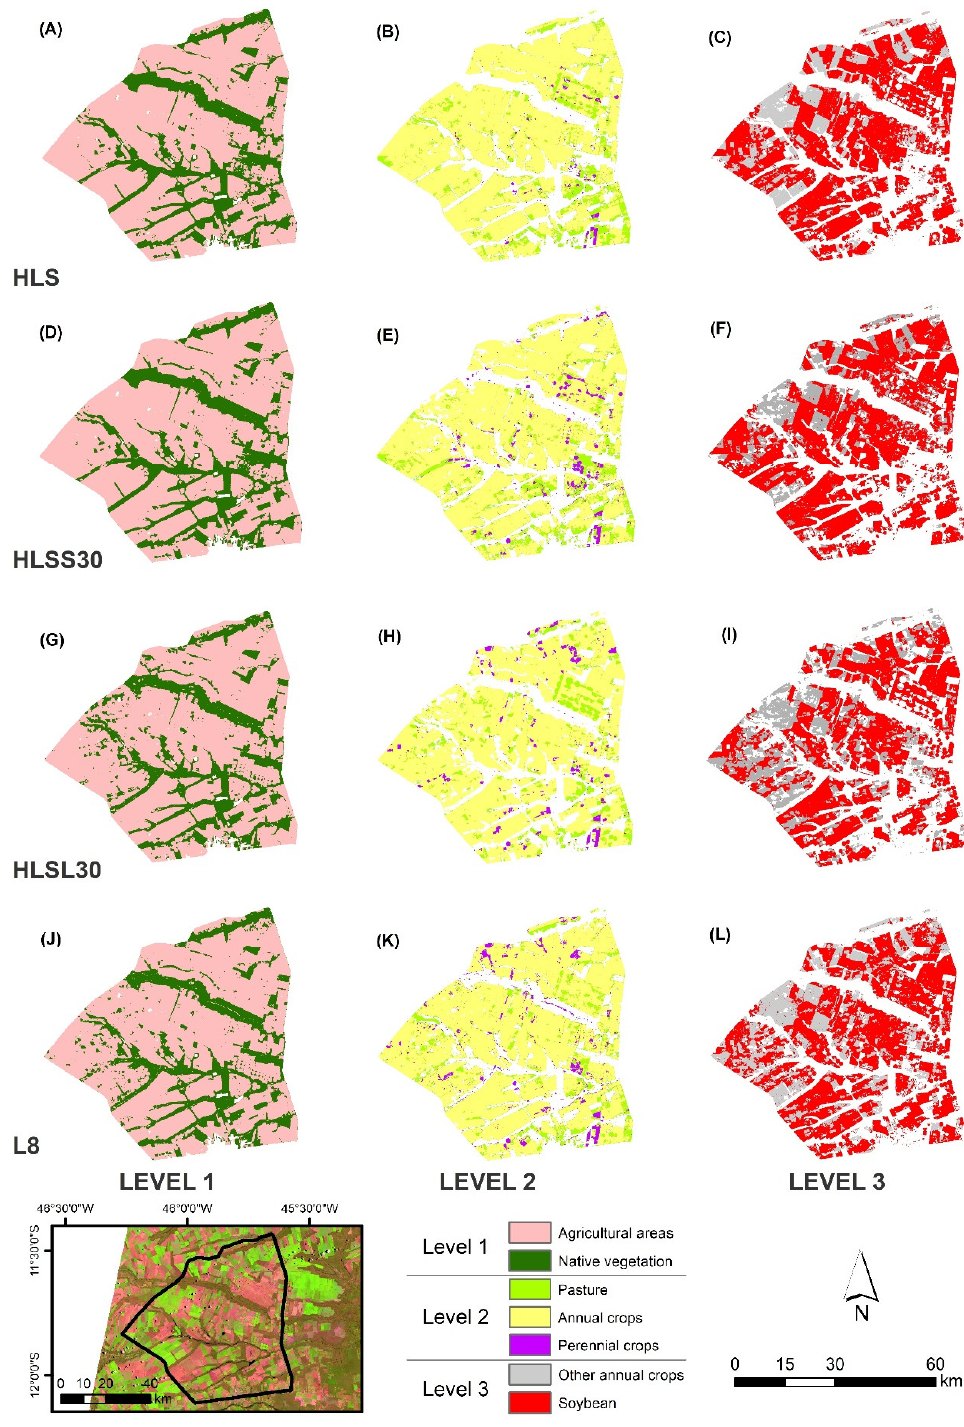
Figure 5. Random Forest classification results, based on Landsat 8 OLI and Harmonized Landsat Sentinel-2 (HLS) scenes, combining multispectral bands and spectral vegetation indices. ( A – C ) correspond to the classifications results involving the Harmonized Landsat Sentinel-2 data set; ( D – F ) correspond to the Sentinel-2 Multi-spectral Instrument Surface Reflectance (HLSS30) datasets; ( G – I ) to the three Landsat Operational Land Imager Surface Reflectance and TOA Brightness (HLSL30) datasets; and ( J – L ) correspond to the Landsat 8 Operational Land Imager (L8) datasets. The color-composition is a Landsat 9 OLI RGB456 acquired on 1 March